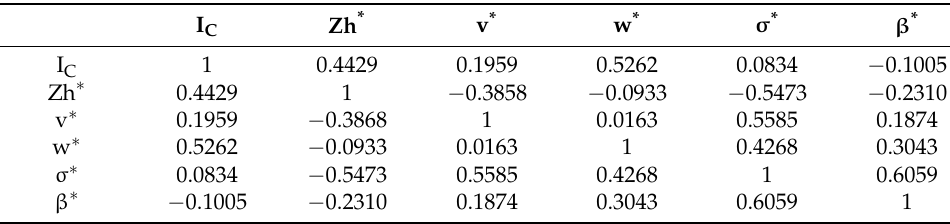
Table 2. Correlation coefficient matrix.